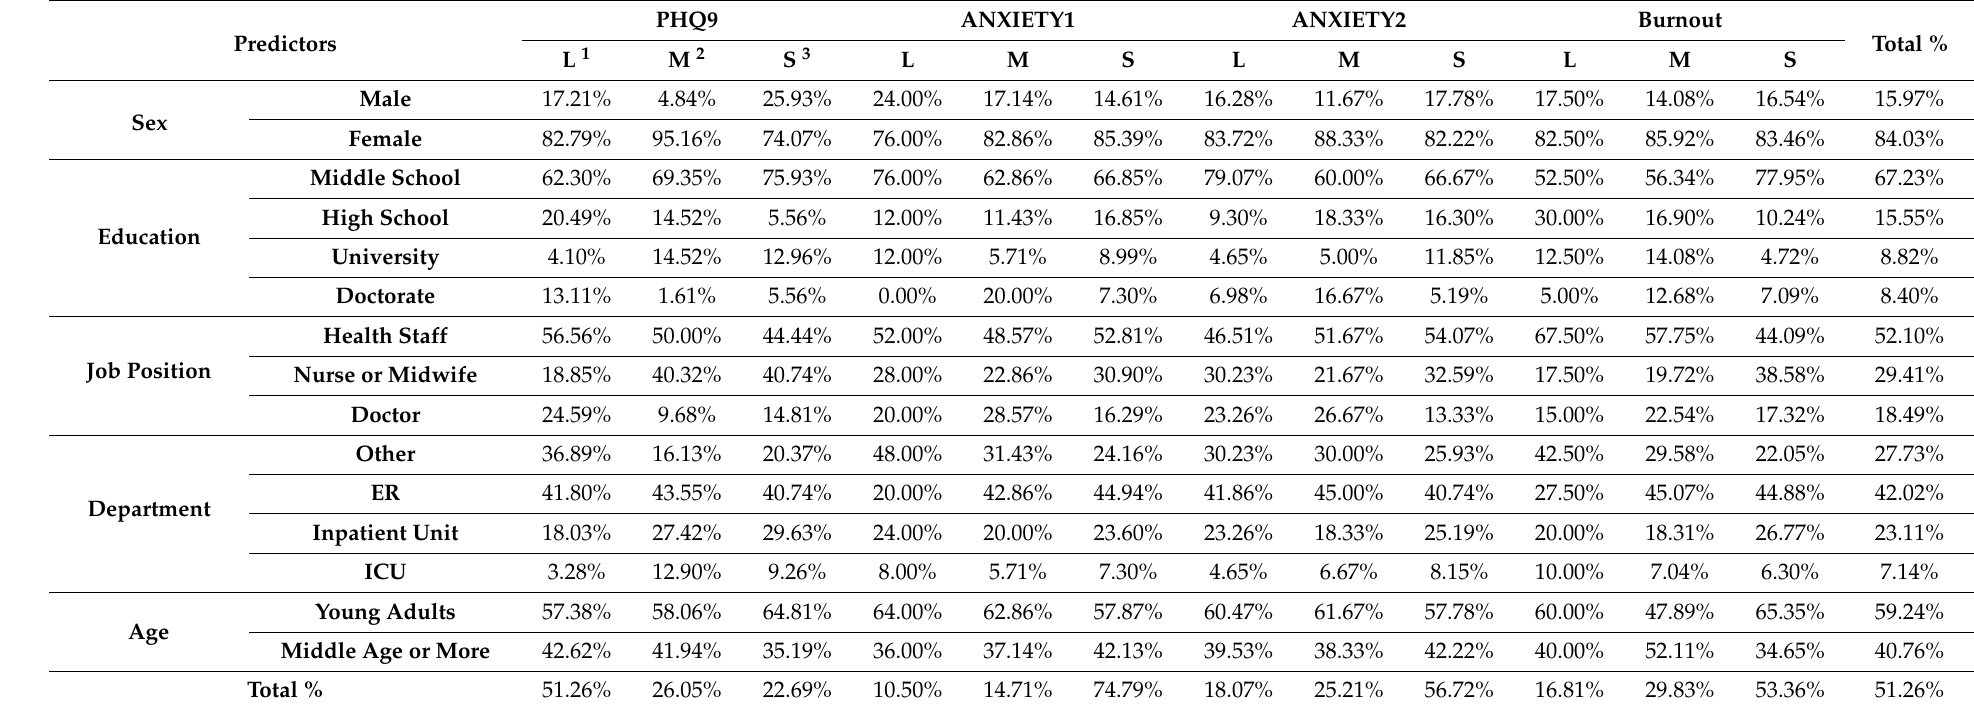
Table 1. Descriptive statistics of emotional health distribution of the